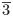
The mass action population dynamics of system Eq (16) in a physical scenario.(a) Solutions of its corresponding ODEs in log-normal scale. Note that populations of molecule 3¯, 5¯ and 8¯ are always the same. (b) The normalised molecule populations for the same period as in (a).